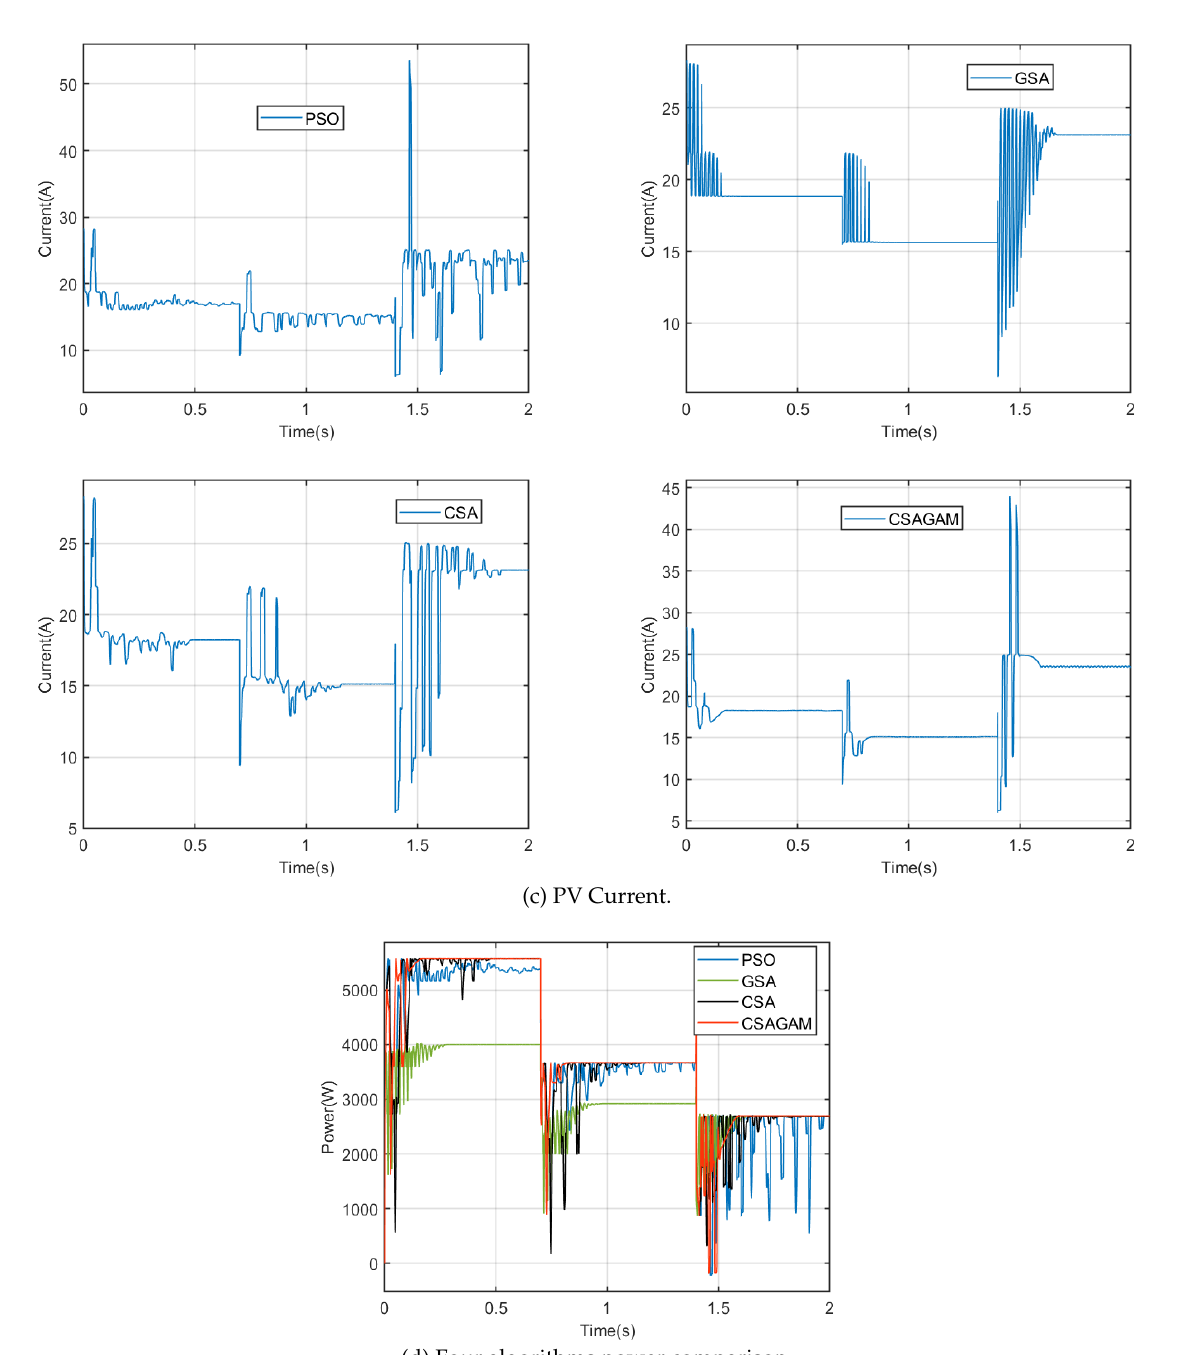
Fig. 9. Simulation results for the changing partial shading PSC 1-PSC 2-PSC 3.